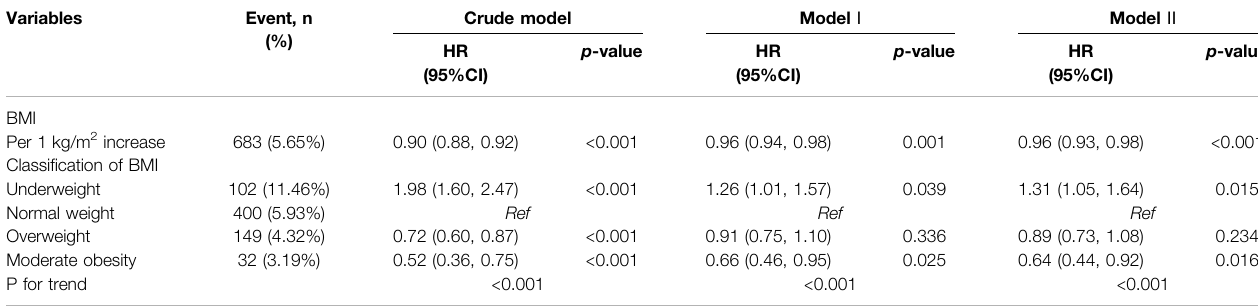
TABLE 3 | Hazard ratios of different BMI categories for all-cause mortality. Variables